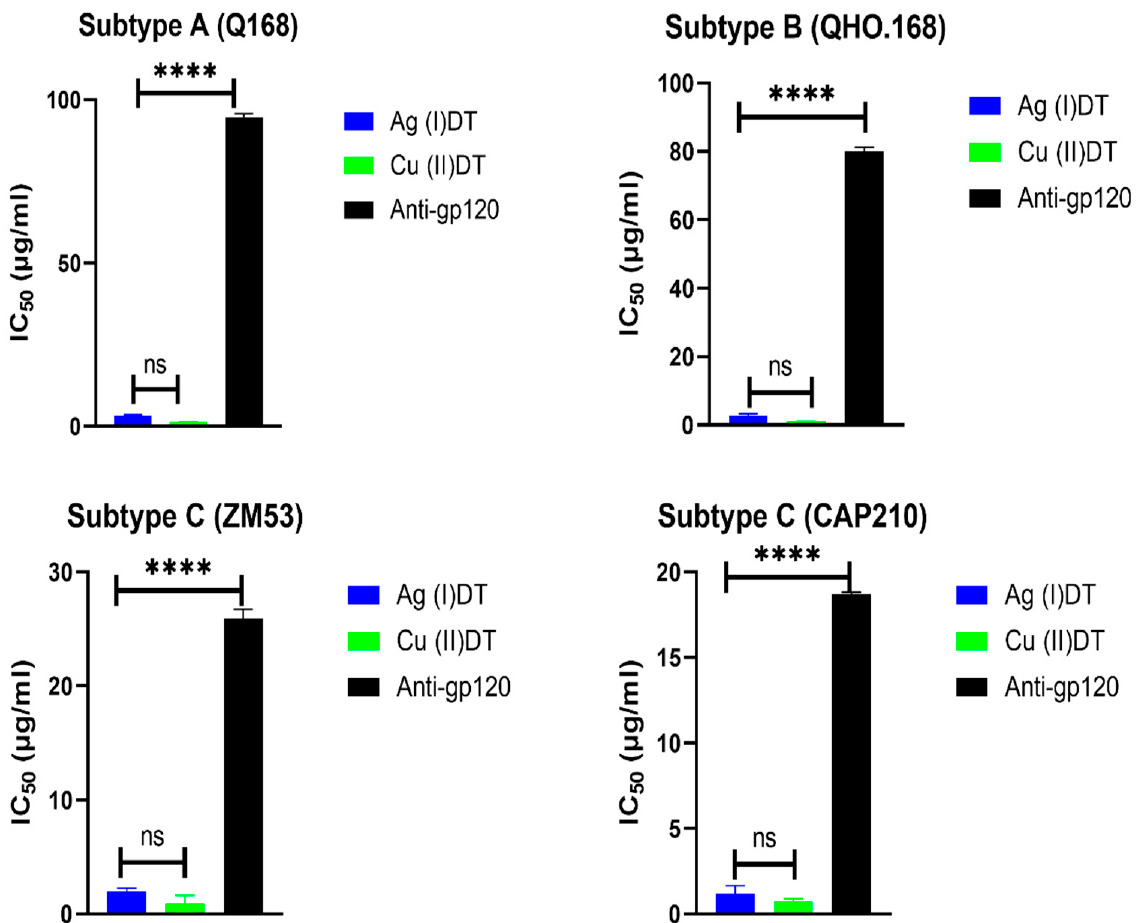
Figure 12. The half-maximal inhibitory concentration (IC 50 ) of the dithiocarbamate complexes of